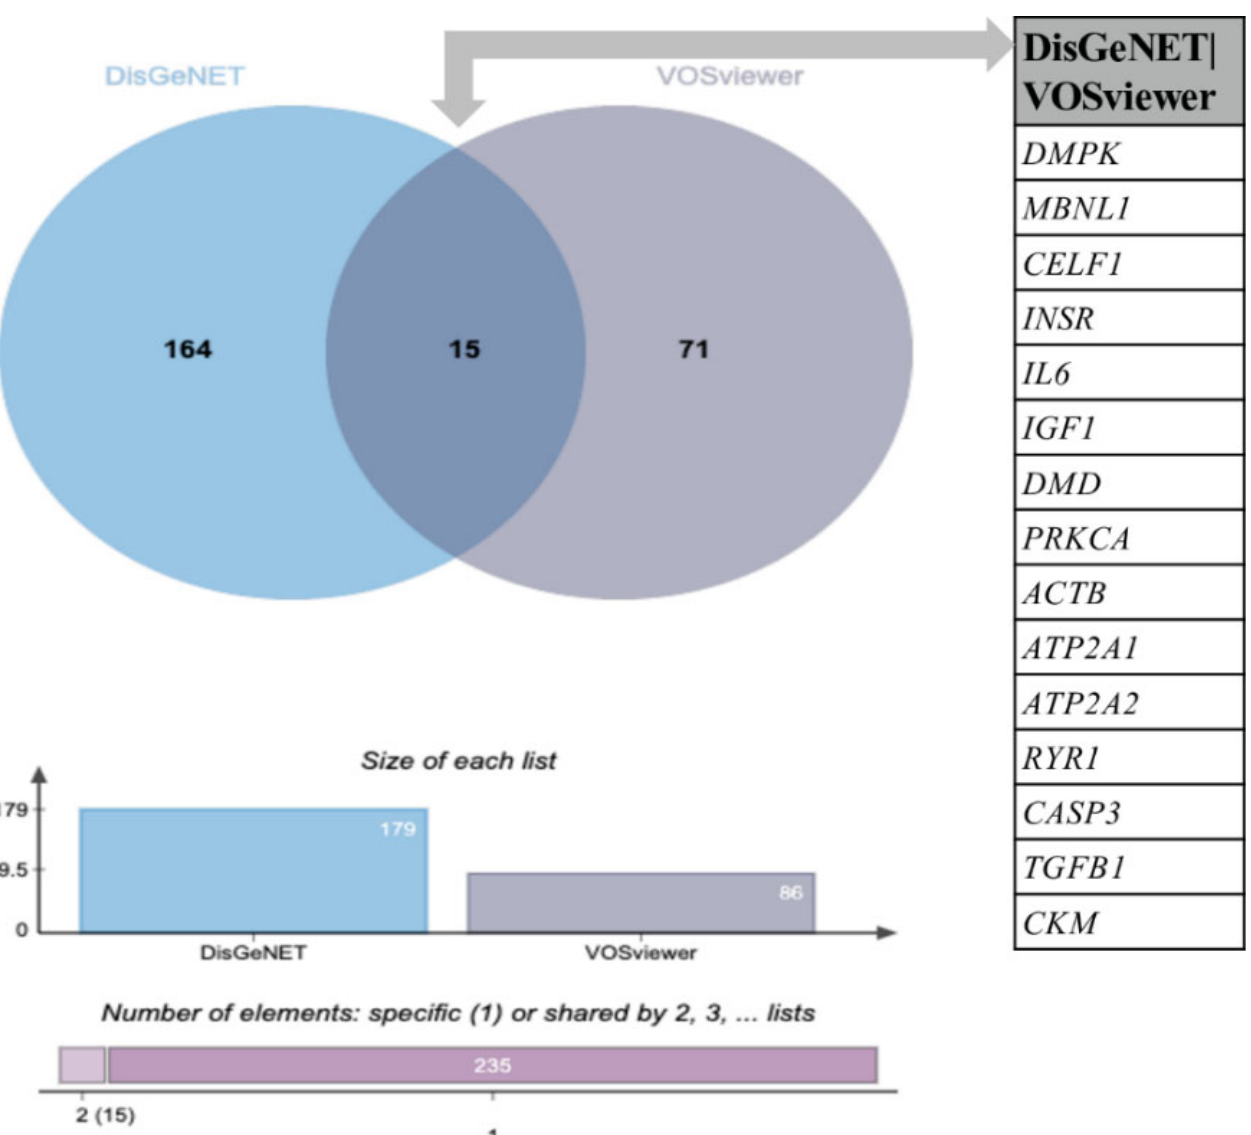
Table 2. Detailed list of common genes identified in DisGeNET and VOSviewer analysis . Proteomics DB (https://www.proteomicsdb.org/(accessed on 21 December 2022) and UniProt (https://www.uni ‐ prot.org/ (accessed on 21 December 2022) were used to investigate the biological processes in which these genes participate. More information on their subcellular localization and molecular function are presented in Table S3. UniProt Accession Number Gene Name